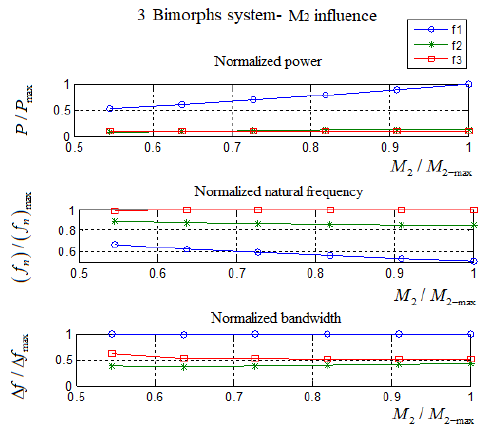
Figure 18. The influence of the normalized middle mass, M 2 , on the output harvested power, natural frequency, and bandwidth (all normalized)—three bimorphs interconnected by two springs case.